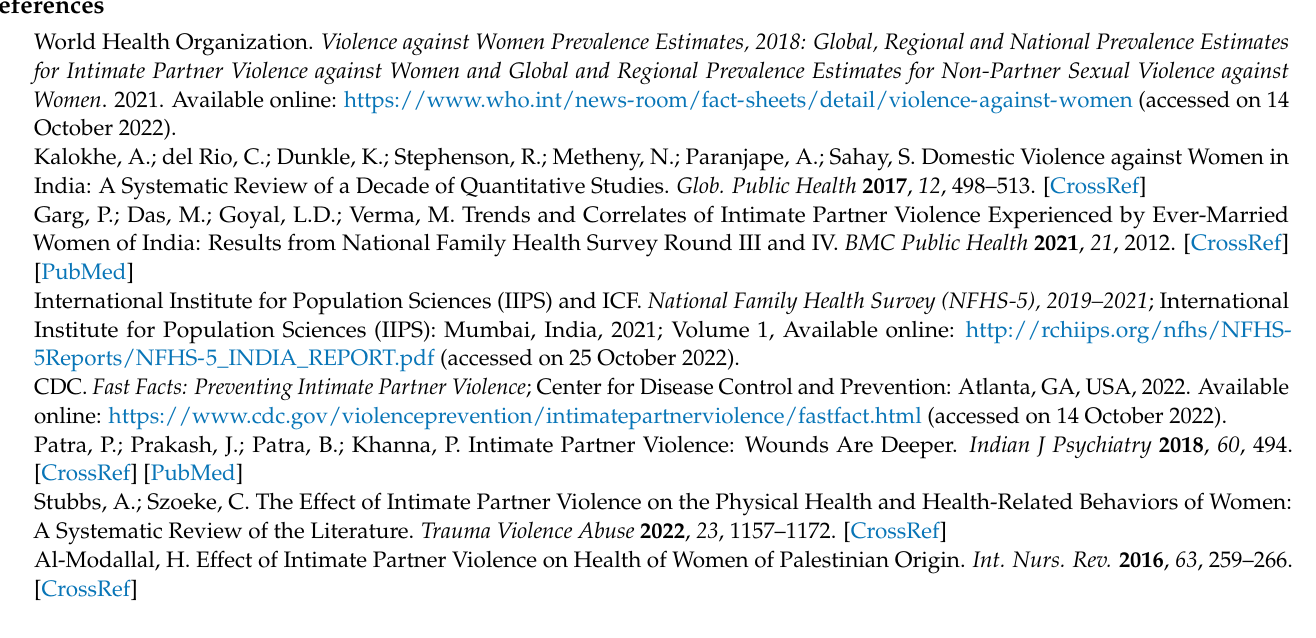
types), Figure S2: Forest plot for Physical IPV Victimization, Figure S3: Forest plot for Psychological IPV Victimization, Figure S4: Forest plot for Sexual IPV Victimization, Figure S5: Forest plot for Approval of